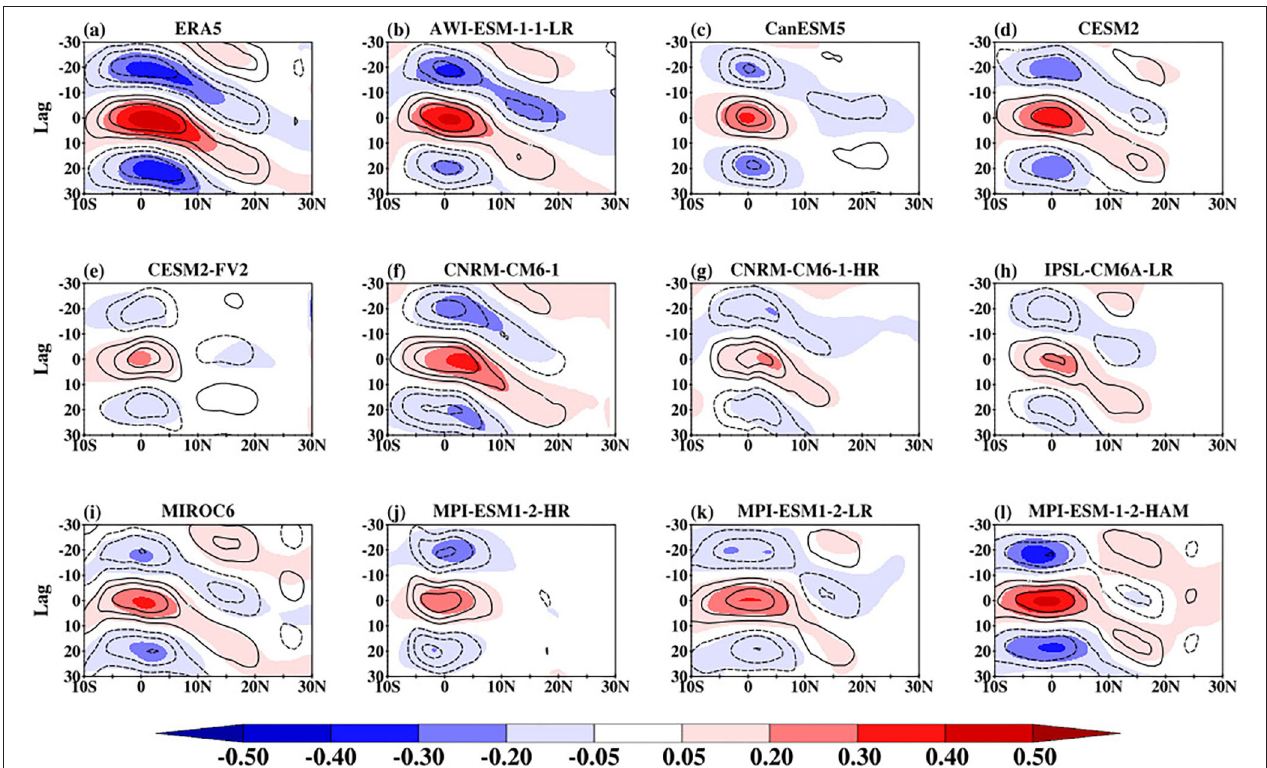
FIGURE 10 | Northward propagation of observed and simulation BSISO convection signal indicated by column integrated MSE (shaded) and 30–60-day rainfall anomalies (contours; starting from ± 0.2 to ± 0.6 at an interval of 0.2) averaged over 80 ◦ E − 100 ◦ E by lag-correlation against 30–60-day rainfall anomalies averaged over the equatorial Indian Ocean (5 ◦ S and 5 ◦ N, 80 ◦ E and 100 ◦